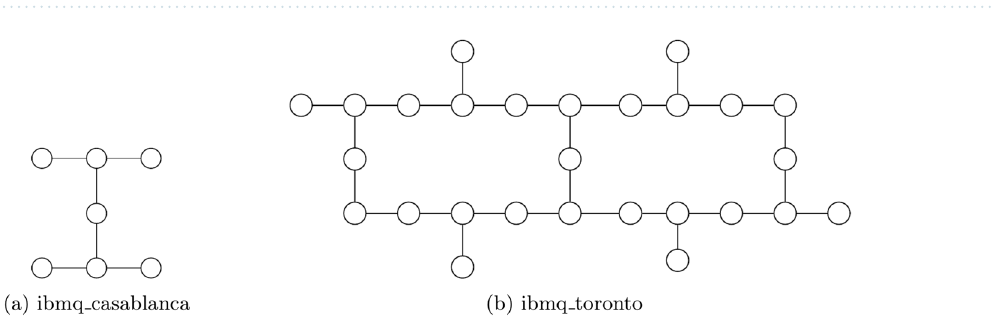
Figure 4. Qubit topology of IBM Q experience processors.